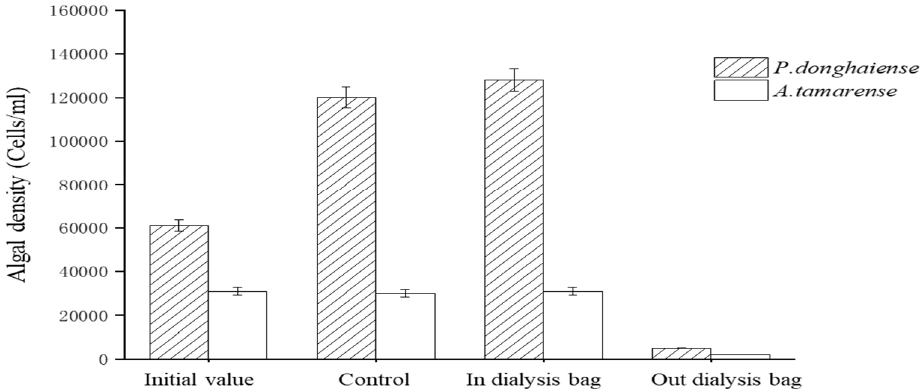
Figure 5. Antialgae effect of the dialysis bag internal and external liquid.